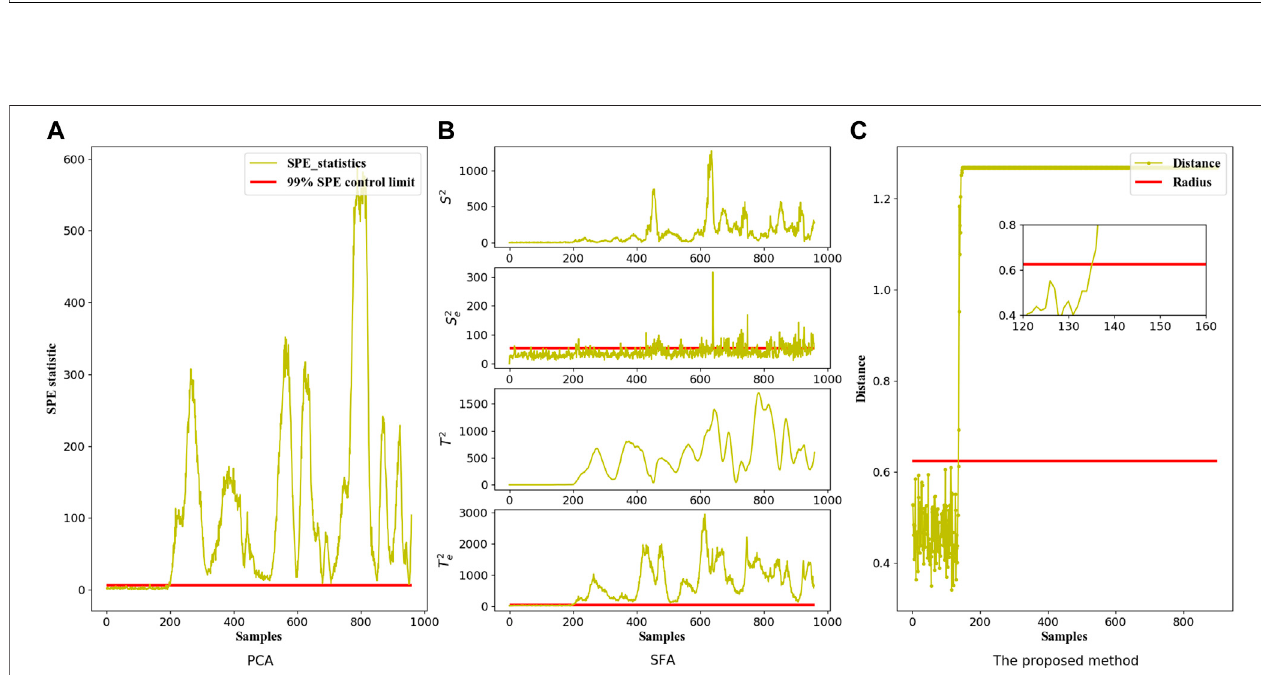
FIGURE 5 | The Fault monitoring graphs of Fault 13 in the TEP dataset corresponding to three different models: (A) PCA model, (B) SFA model and (C) The proposed multi-scale model.